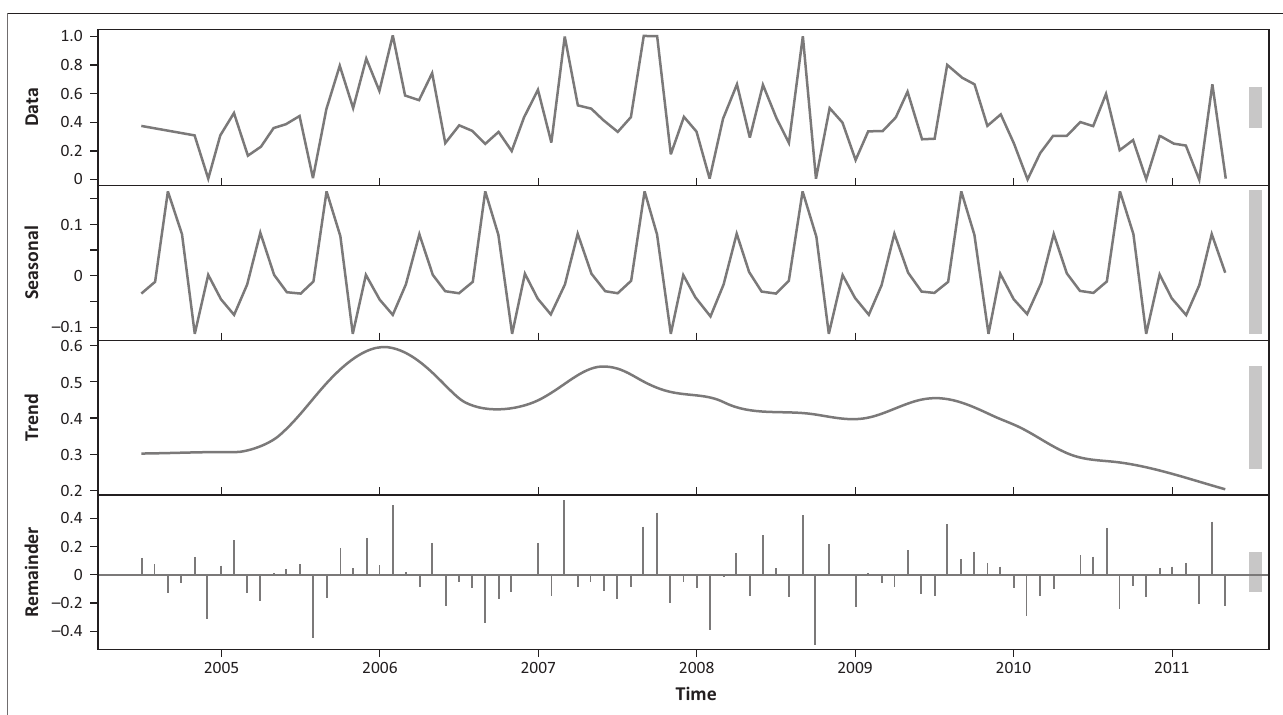
FIG URE 3: Time series of resistance of Staphylococcus aureus to ampicillin, showing the data, trend, seasonal effects and the remainder.